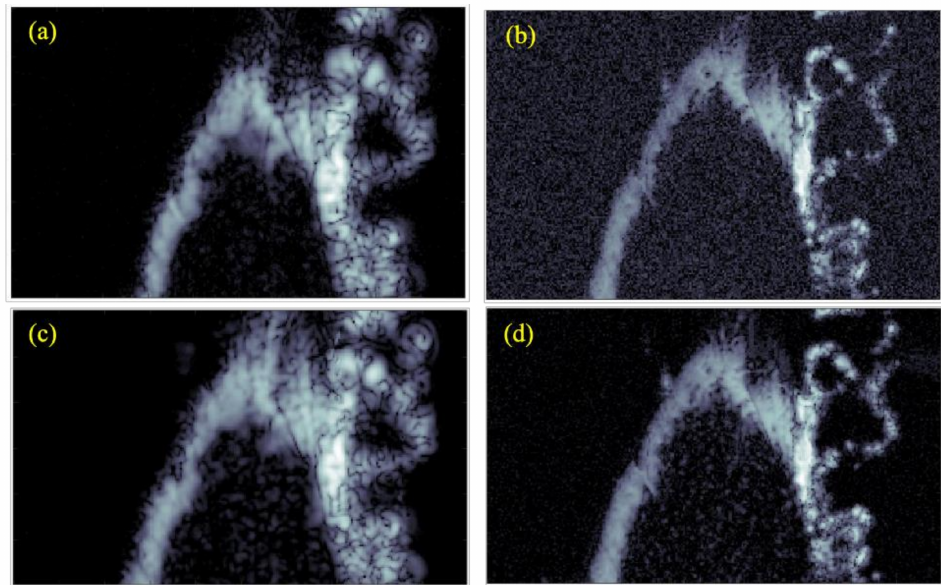
Figure 7. C-scan images generated of the test sample using different transducers and excitation pulses. These are ( a ) commercial transducer with Ricker wavelet, ( b ) in-house transducer with Ricker wavelet, ( c ) commercial transducer with chirp code, and ( d ) in-house transducer with chirp code. All images have a dimension of 3 × 5 mm 2